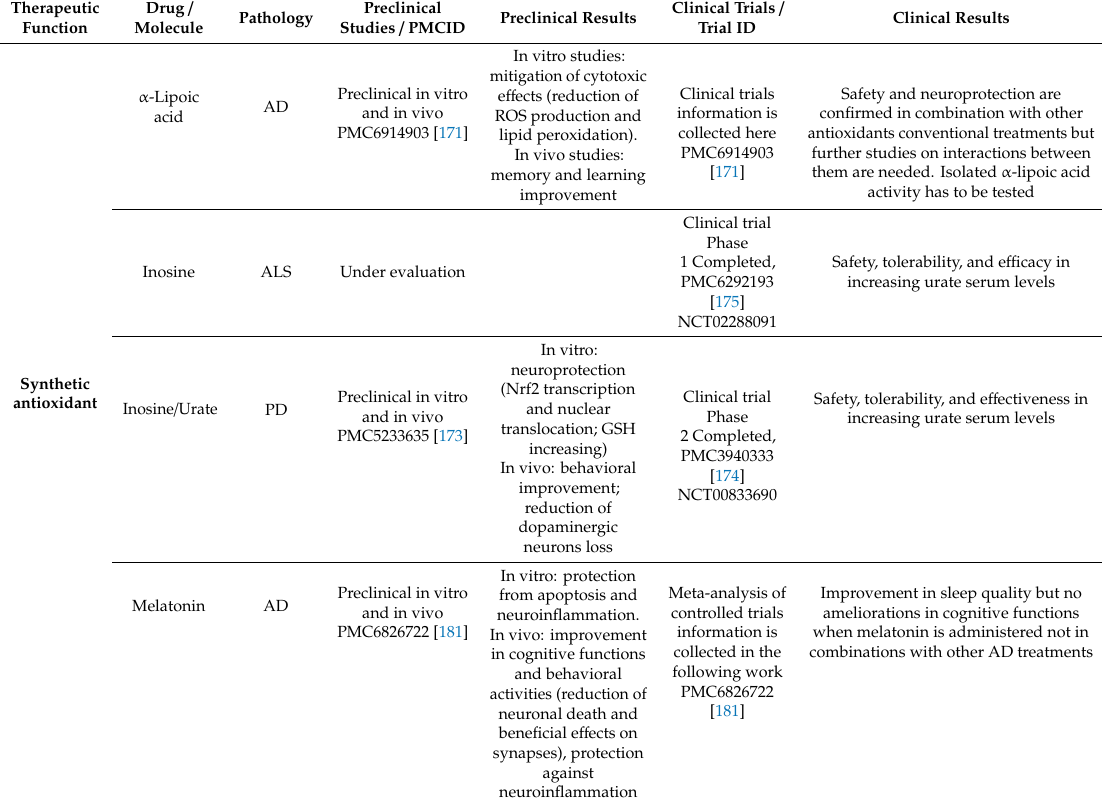
Table 2. Antioxidant compounds for neurodegenerative disease treatment. The table lists synthetic and natural antioxidant compounds tested for the treatment of neurodegenerative diseases both in preclinical and clinical studies. The most recent and promising studies are collected here. For clinical trial ID we referred to https: //